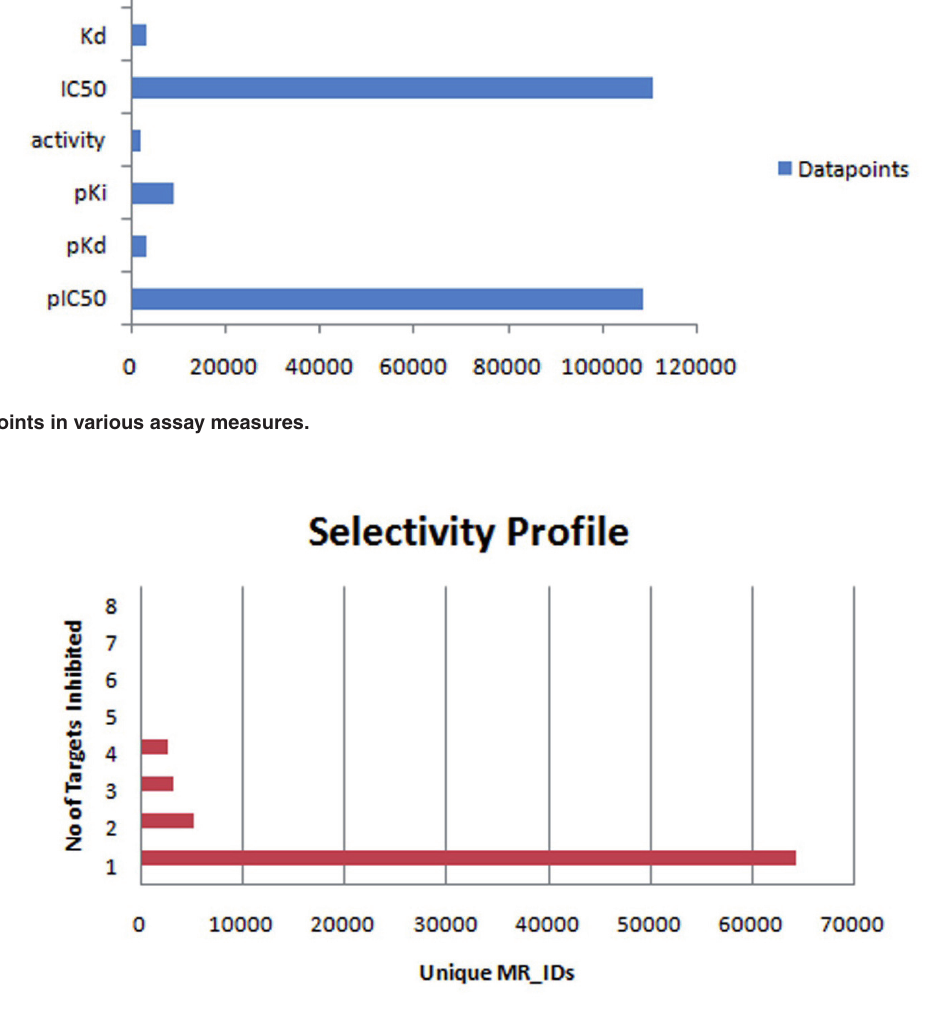
Figure 4. Selectivity profile for data